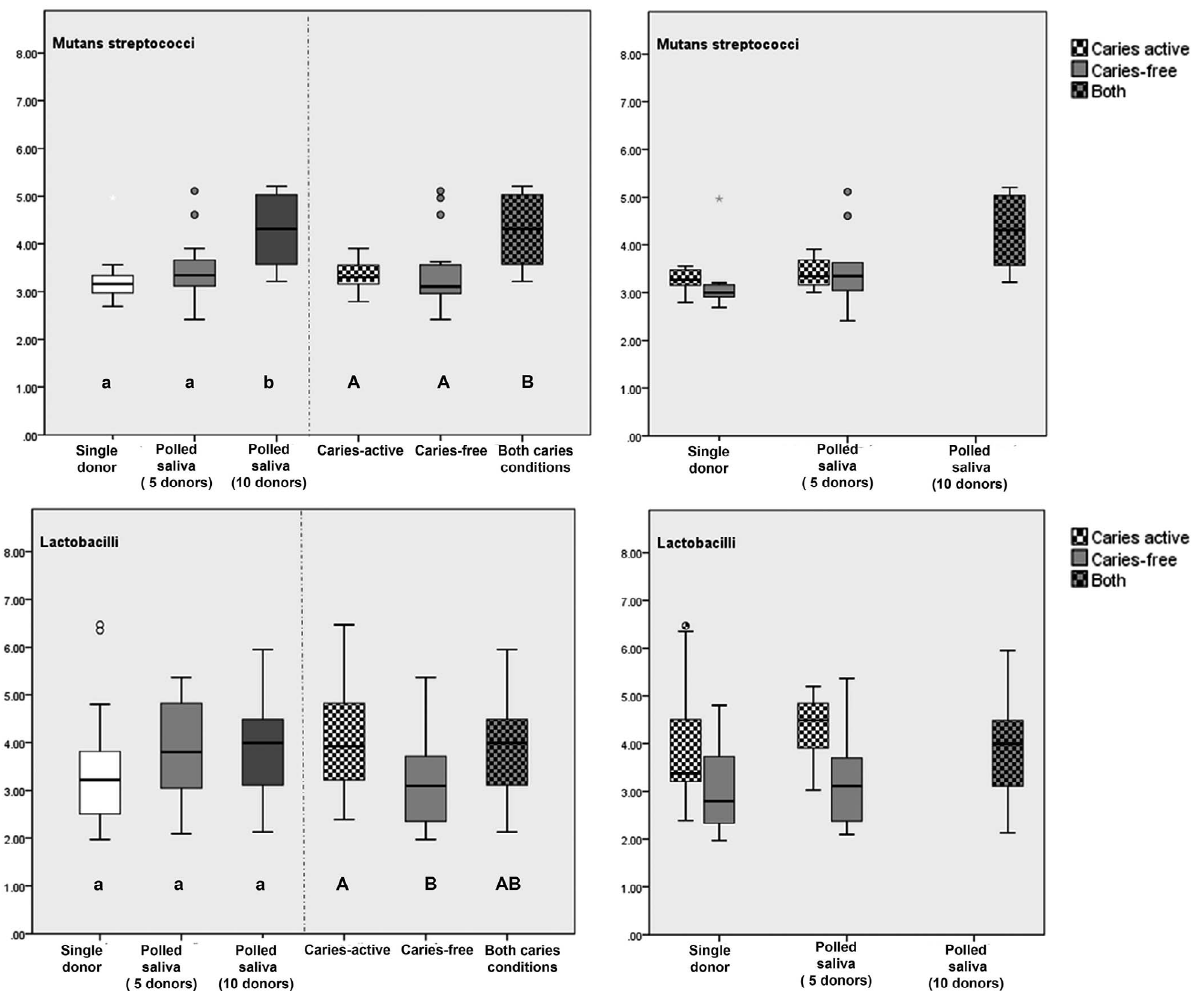
Figure 3- Lactobacilli and Mutans streptococci counts (CFU log mg -1 ) and (SD) according to caries activity and inoculum levels (right side) and statistical set-up (left side). Upper case letters show statistical difference between caries activity (caries free, caries active or both). Lower case letters show statistical difference among inoculum level (single donor, pooled saliva from 5 donors and 10 donors). The circles represent outliers and the asterisks extreme